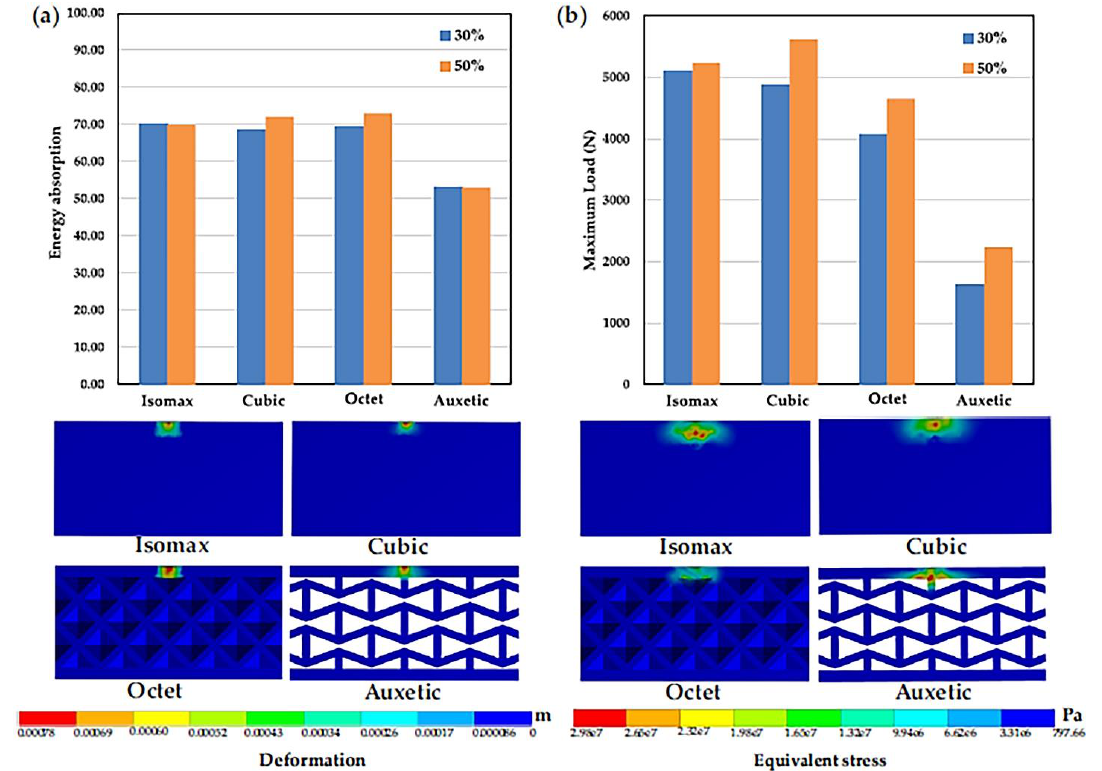
Figure 10. Impact properties of 3D printed meta sandwich plates with Isomax, octet, cubic, and auxetic cellular cores under low velocity impact: ( a ) Energy absorption and ( b ) Maximum load [101]. Reproduced with permission from Elsevier.